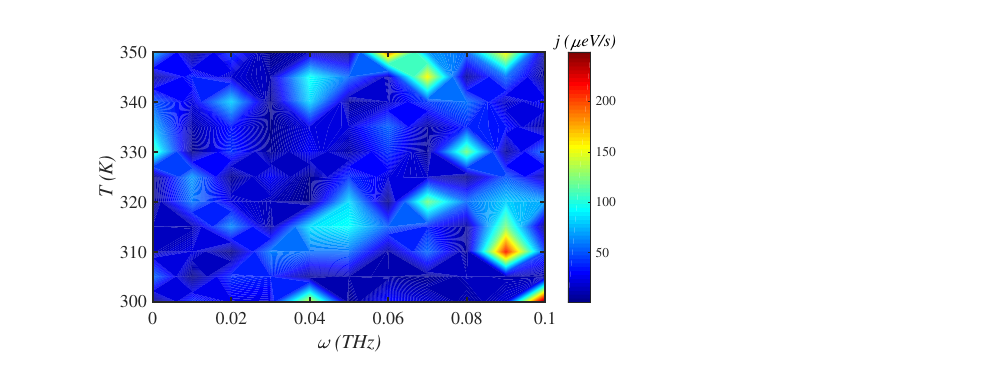
Figure 9. The energy flux j map through a N = 150 site protein chain under the simultaneous effects of temperature T and frequency ω of external mechanical load at a fixed force magnitude, F 0 = 2